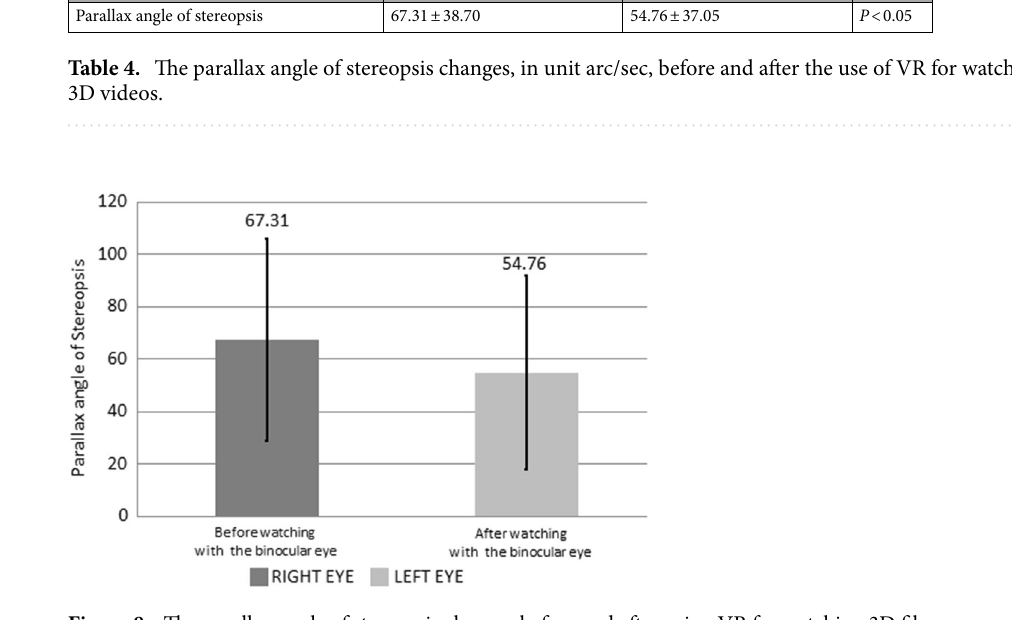
Figure 8. The parallax angle of stereopsis changes before and after using VR for watching 3D